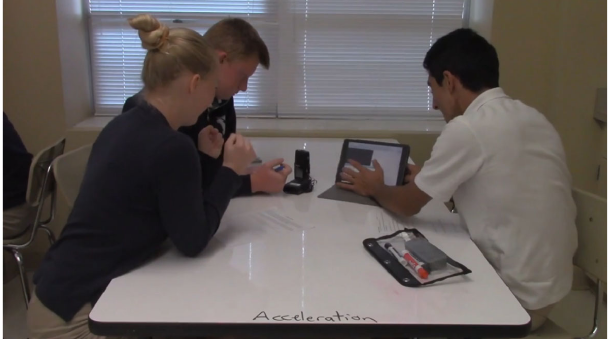
FIG. 8. Image of a group of students experiencing success while working through a computational